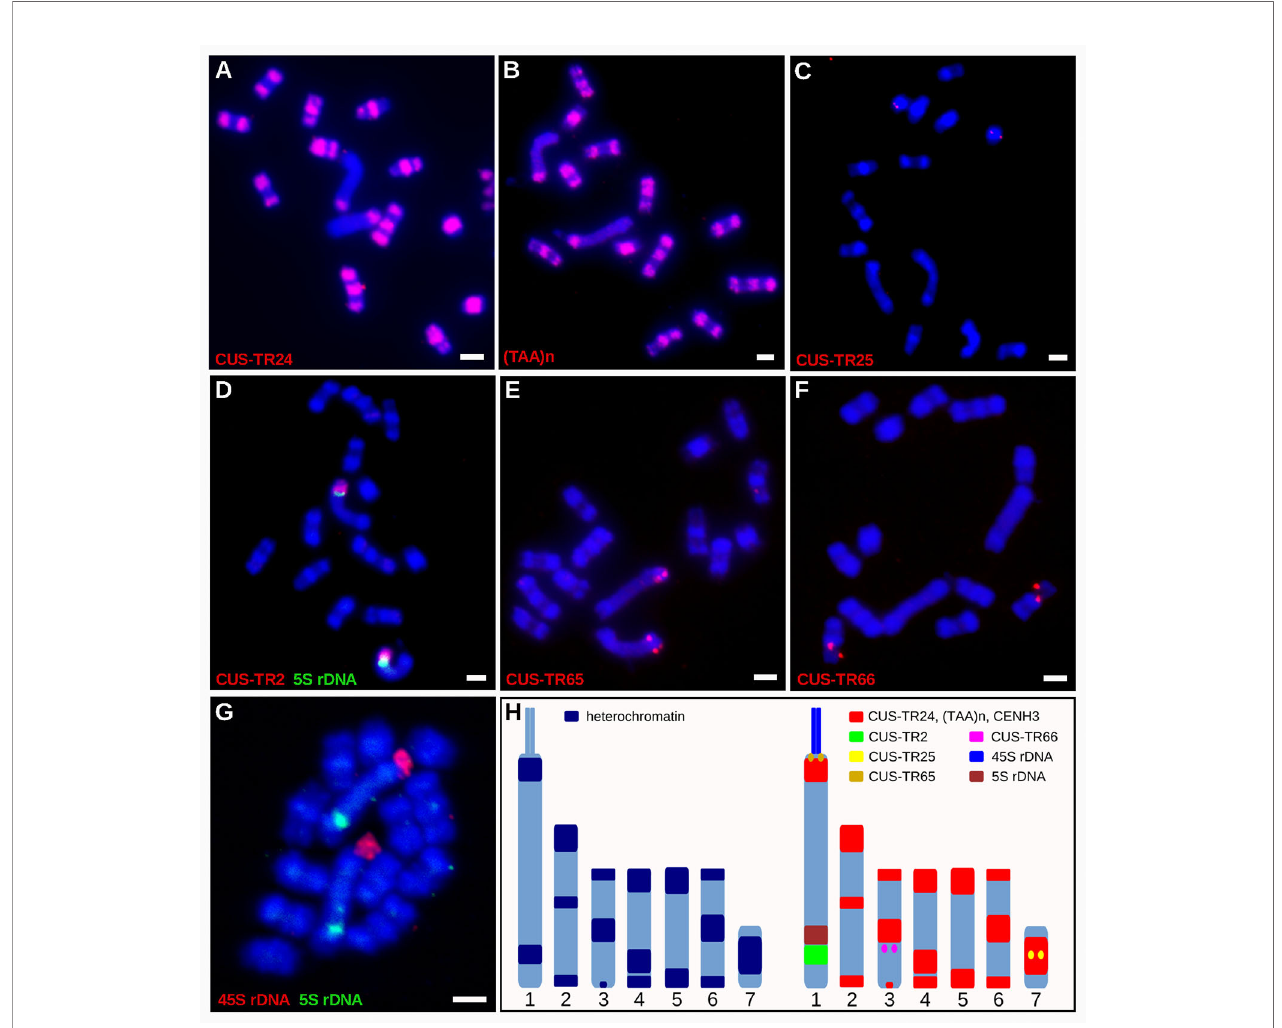
FIGURE 4 | Distribution of satDNA families on chromosomes of C. europaea , investigated by FISH. (A) CUS-TR24, (B) (TAA)n, (C) CUS-TR25, (D) CUS-TR2 and 5S rDNA, (E) CUS-TR65, (F) CUS-TR66, (G) 45S and 5S rDNAs. Note that 45S rDNA localized to a chromatin tail protruding from one terminus of the largest chromosome 1. The presence of the tail helped to distinguish the CENH3-containing (proximal to the tail) and CENH3-lacking (distal from the tail) heterochromatin domains on this chromosome. Chromosome morphology, size, and repeat distribution patterns allowed us to distinguish all seven chromosome types in C. europaea . (H) Ideograms summarizing distribution of heterochromatin domains (left), and satDNA families and rDNA repeats (right). CUS-TR67 is not included because it was dif fi cult to detect and its distribution could not be precisely determined. Scale bars = 2